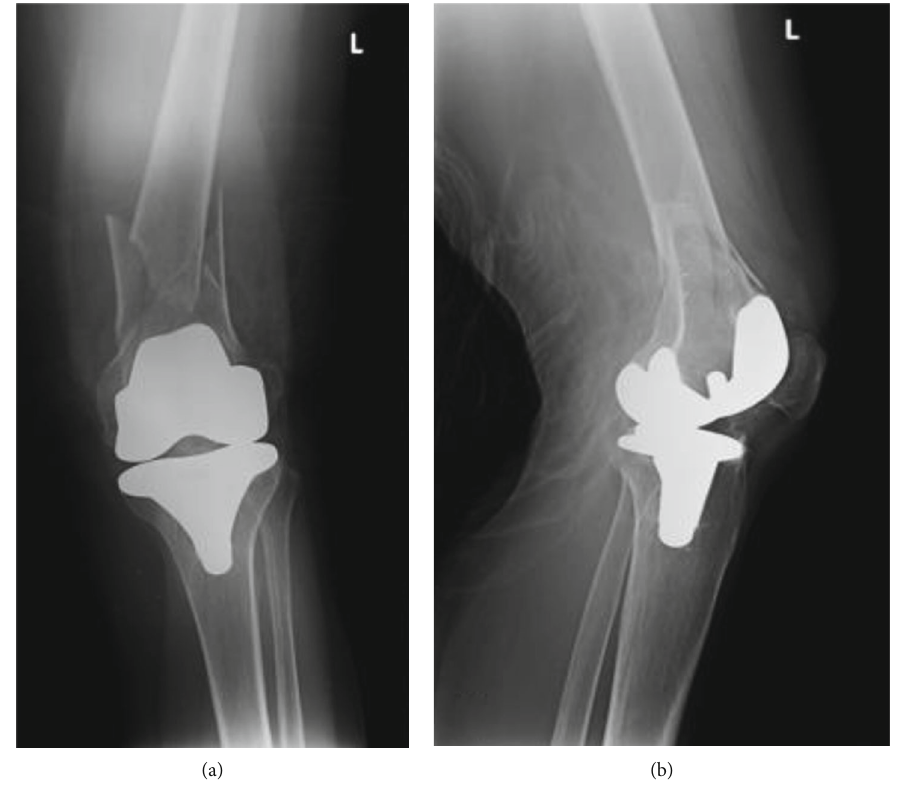
Figure 1: Preoperative A-P (a) and lateral (b) radiographs showing a complex left supracondylar distal femoral fracture adjacent to a total knee